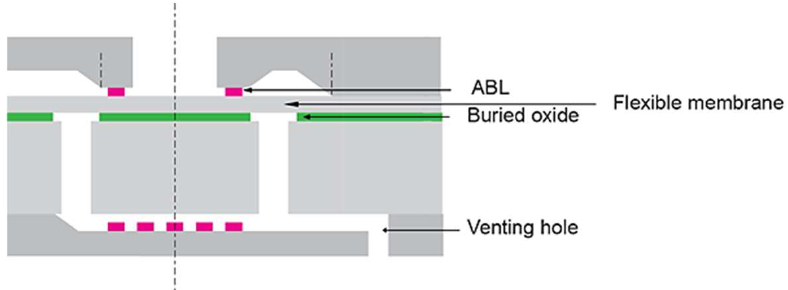
Figure 4. Schematic cross-section of an outlet valve with a venting hole that can be used to control pneumatically the opening and closure of the valve. The Anti-Bonding Layer (ABL) in pink is deposited onto the top wafer to a downward shift of the valve and thus a pretension (valve normally closed). The membrane in the middle wafer (SOI—buried oxide in green) is 15 microns thick [28]. The venting hole is machined in the bottom wafer. Other dimensions are not disclosed because the methods described below are not specific to this model but generic to membrane pumps.